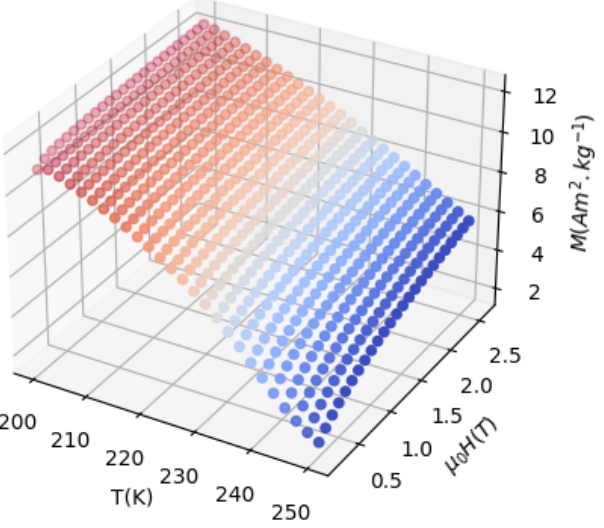
Figure 6. Magnetization vs. temperature for and SmNi 2.2 Fe 0.8 under several magnetic